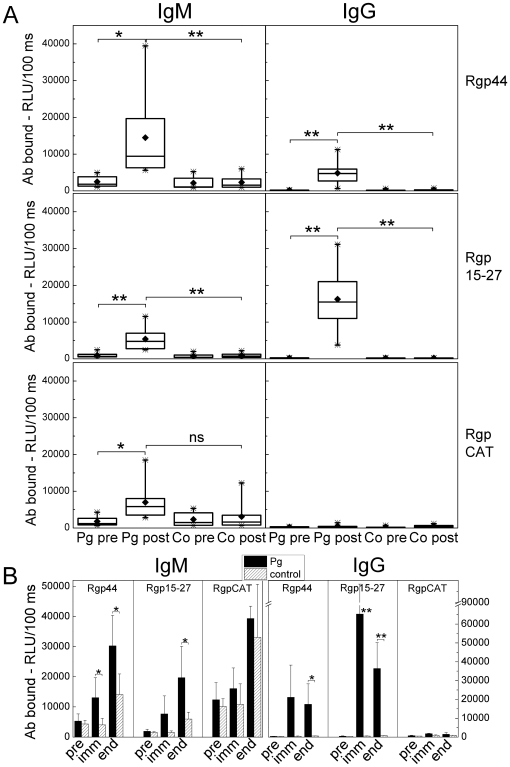
Antibodies to recombinant gingipain in P. gingivalis immunized mice.Recombinant proteins of the arginine specific gingipain protease of P. gingivalis were produced in E.coli: two proteins in the hemagglutinin/adhesion domain, Rgp44 and Rgp15–27, and the catalytic domain, RgpCAT, which were used in chemiluminescence immunoassay to determine mouse plasma (1∶500) IgM and IgG binding in P. gingivalis immunized (Pg) and control (Co) groups in both A) C57BL/6 and B) LDLR−/− mice. A) For C57BL/6 immunized and control mice the samples (n = 8 each) were determined as duplicate before (pre) and after (post) immunization. Box-plots represent the distribution of the means of the sample duplicates. B) Two plasma samples within the group were pooled for immunized (black bars) and control (hatched bars) LDLR−/− mice and measured in duplicate. Samples were collected before (pre), after the second booster immunization (imm) and at the end of HFD (end). Columns represent the mean ± SD of pooled samples in each group. **P<0.01 and *P<0.05.